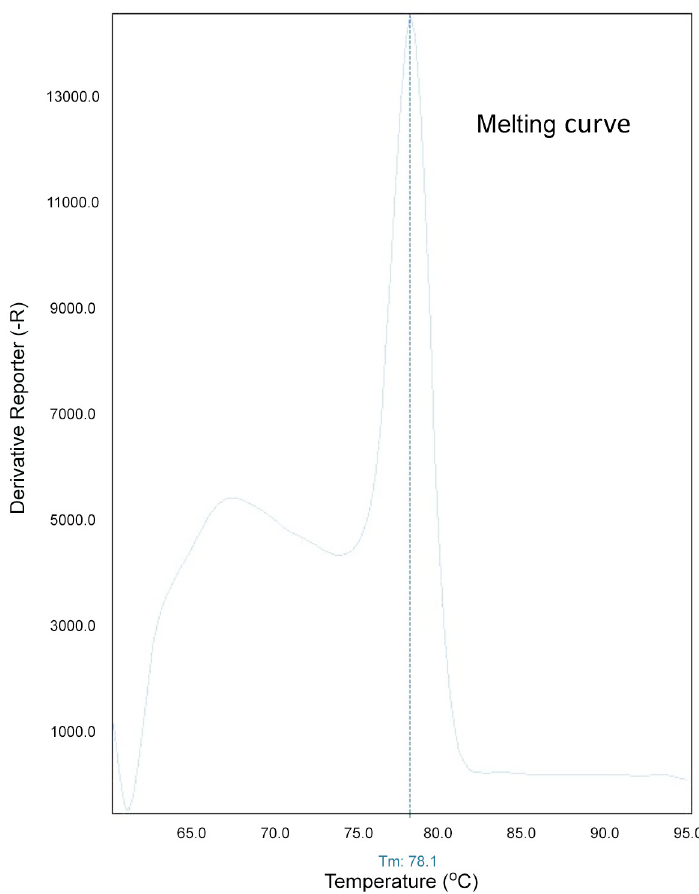
Fig 1. Melting curve for SV-A qPCR on the Step One Plus. Standard plasmid DNA containing SV-A gene fragment was used as the template for amplification in a SYBR green based qPCR reaction. RT-qPCR product had a melting temperature of